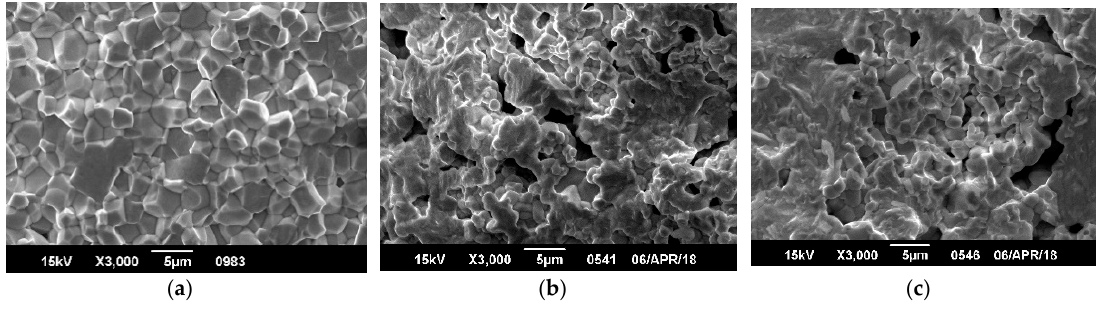
Figure 4. Fragments of microstructures of SS ceramics obtained in backfill ( 𝑇 𝑠𝑖𝑛𝑡. = 1500 K ( a ); T sint . = 1520 K ( b )) and without it ( 𝑇 = 1520 K ( c )).